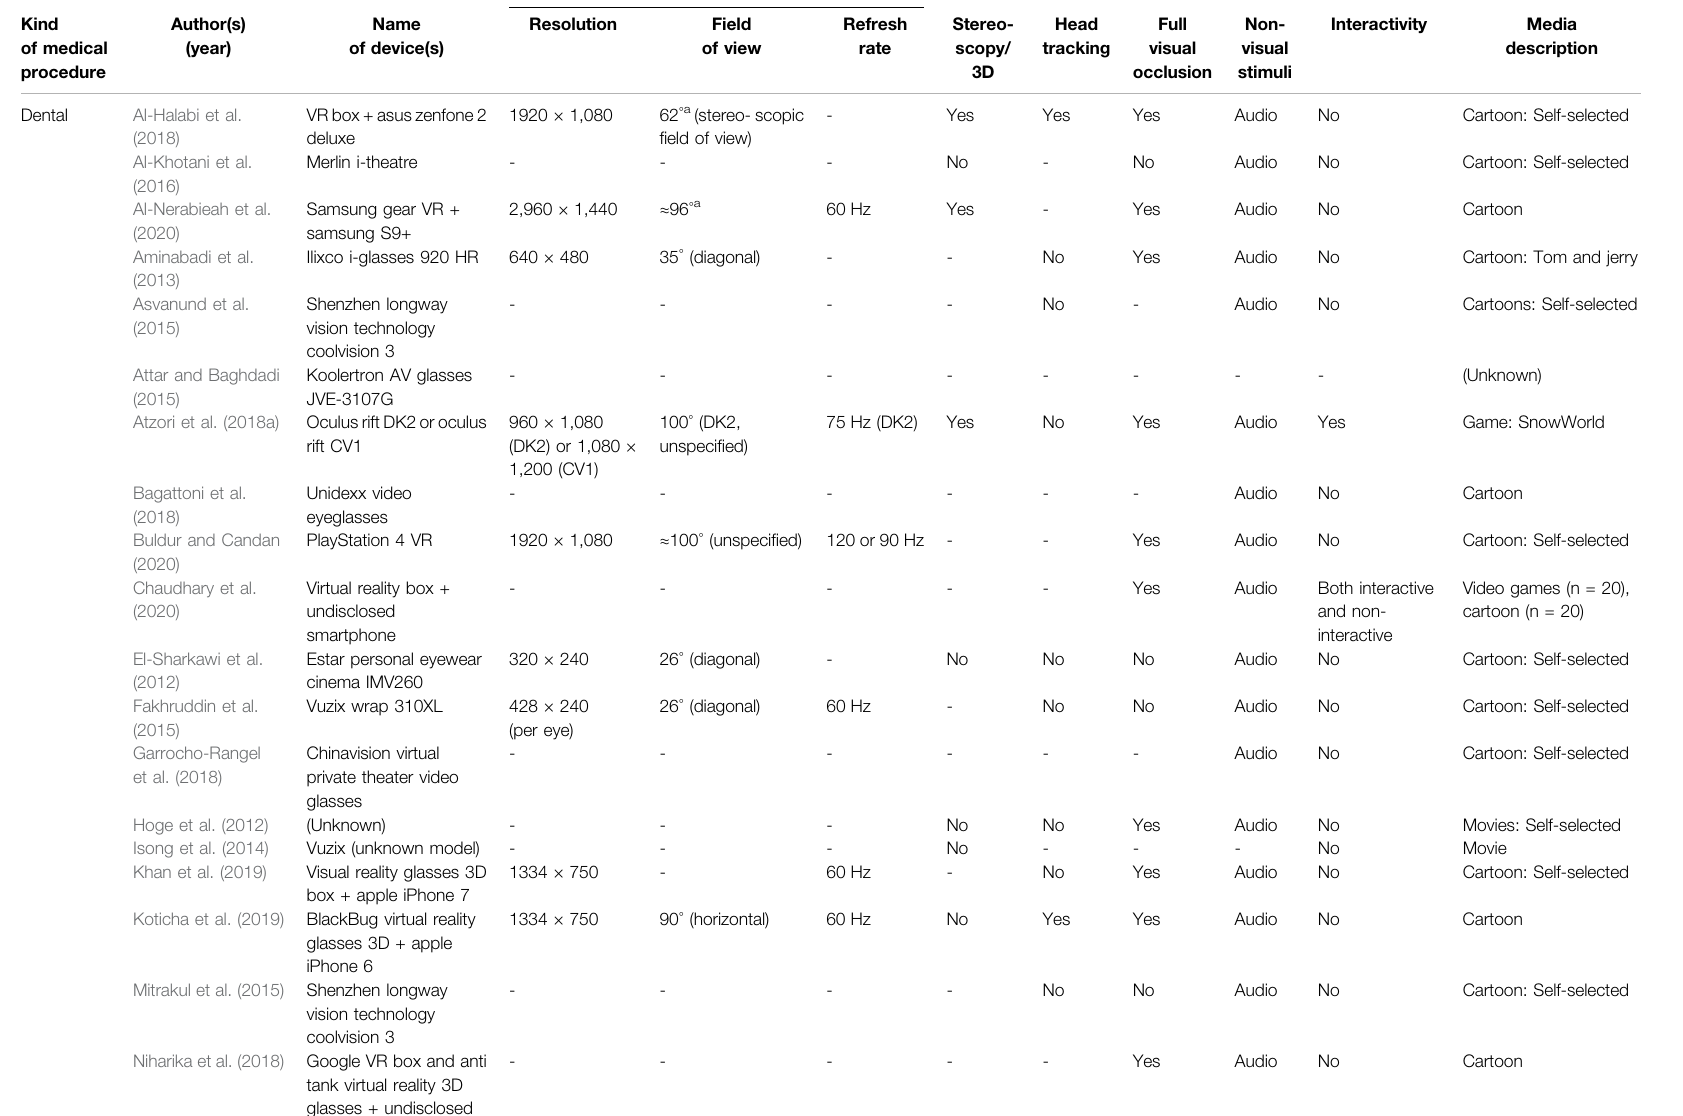
TABLE 3 | Characteristics of VR systems and